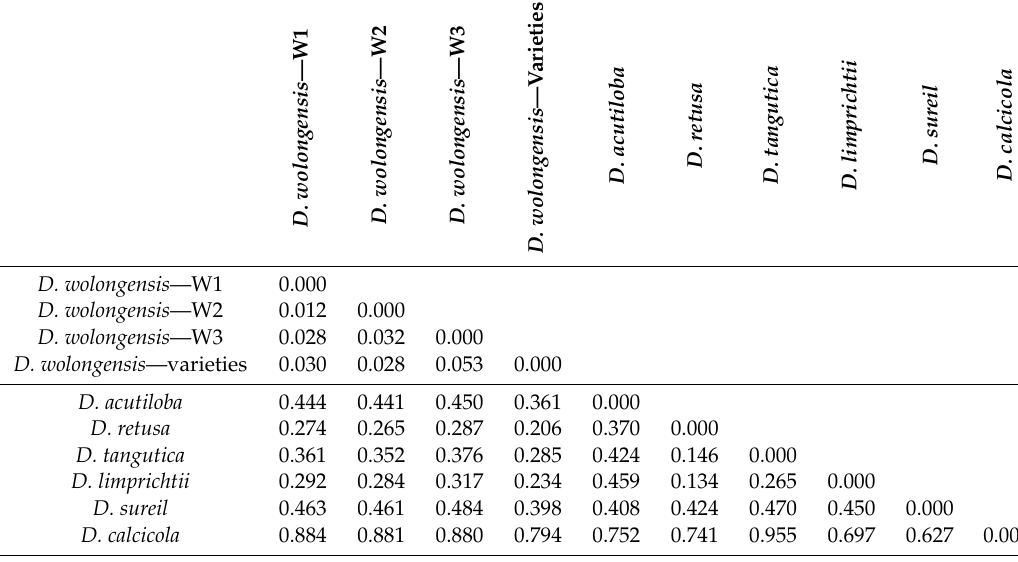
Table 3. Matrix of genetic distances between Daphne species / populations based on Nei’s unbiased distances